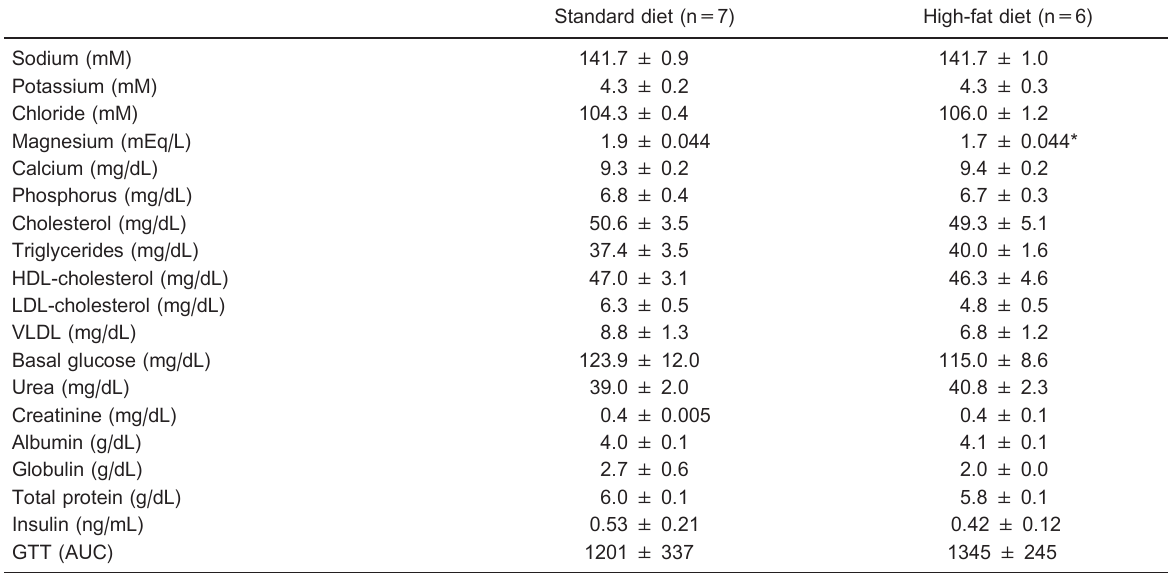
Table 1. Serum biochemistry data for 10-week old age-matched rats receiving a standard diet or a high-fat diet for 4